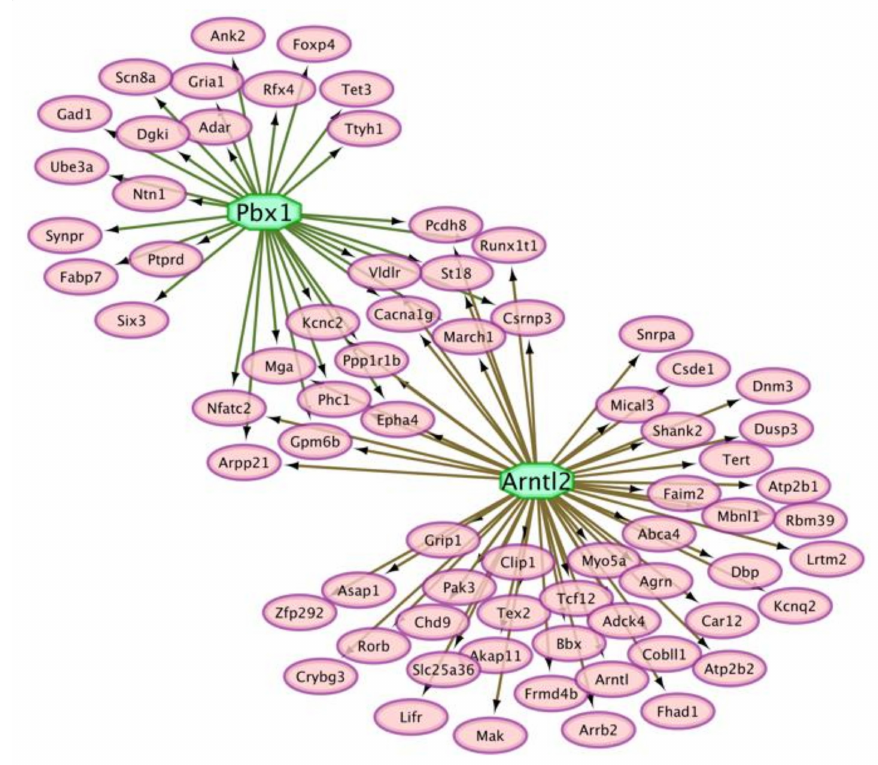
Figure 5. Enriched transcription factors (octagons) including motifs on the regulatory regions of genes (ovals) that presented absolute or relative differential splicing between opioid-induced hyperalgesia and control mice in the trigeminal